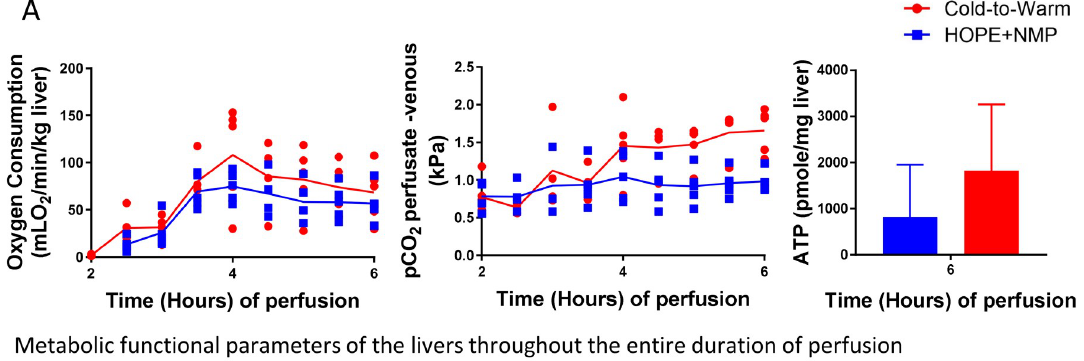
Perfusate lactate levels were similar at the start of the perfusion (HOPE+NMP 4.7 [2.5–7.4] vs.